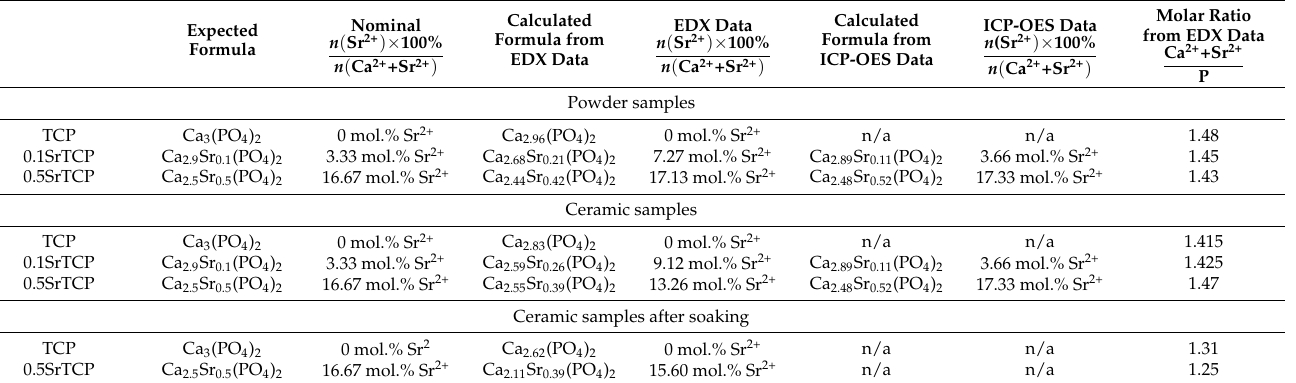
Table 2. Chemical composition of TCP and SrTCP samples obtained by EDX and ICP-OES data. The values are given with a relative error of